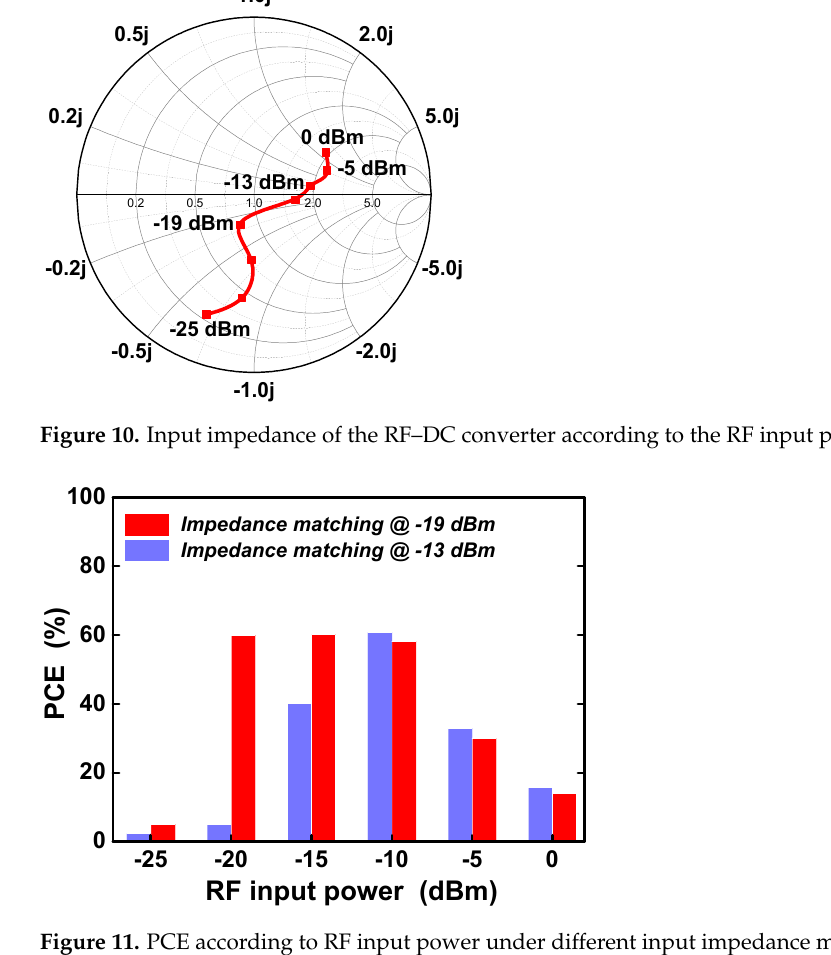
Figure 12. Chip layout of the proposed CMOS RF–DC converter.